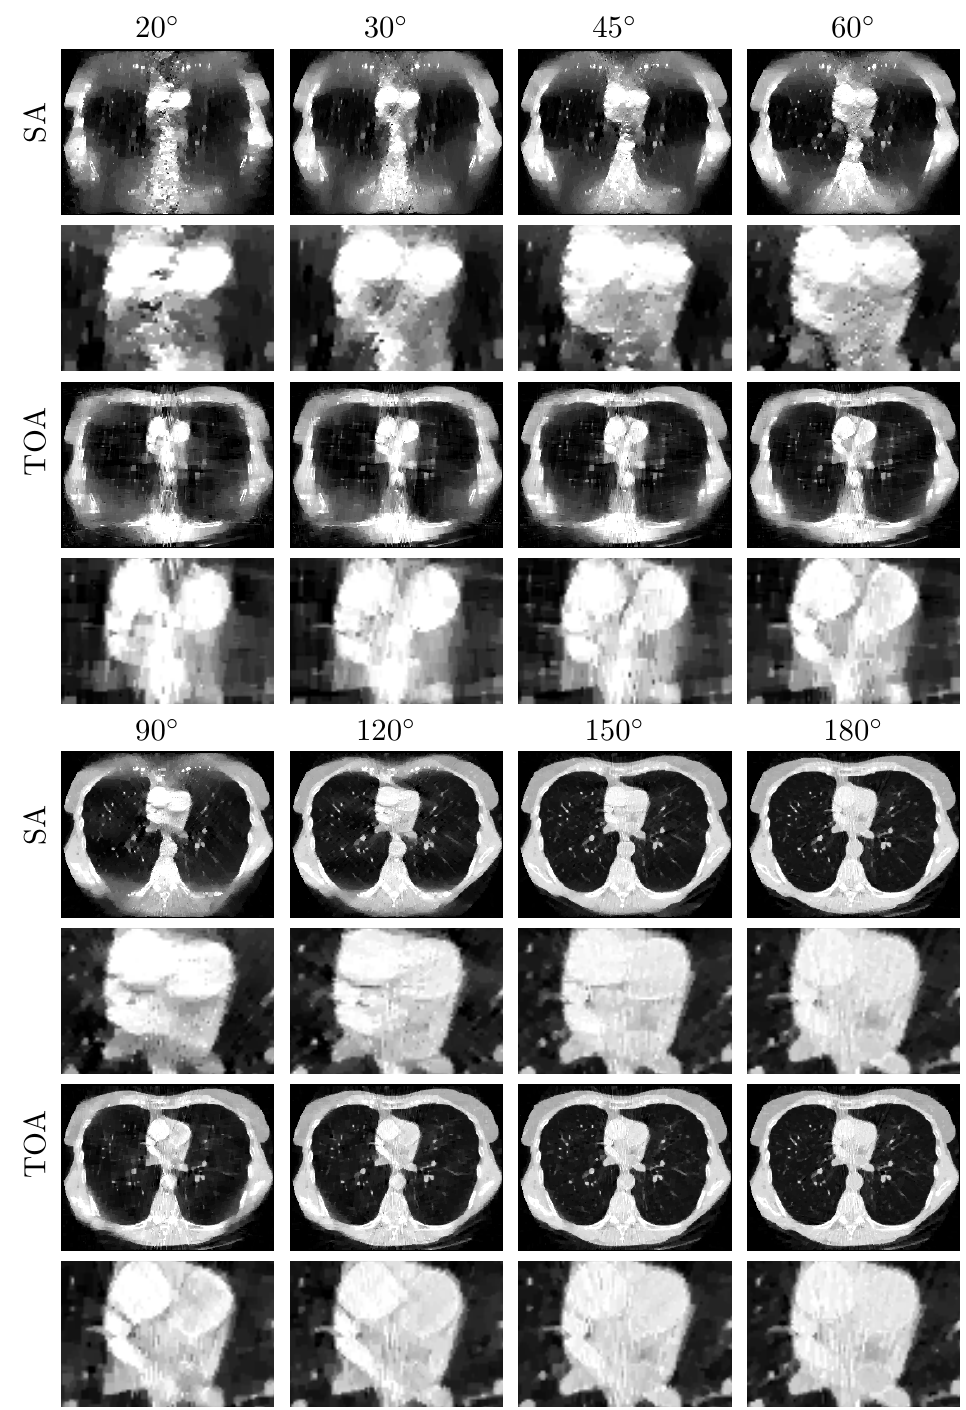
Figure 7. VMIs (rows 1, 3, 5, and 7), along with their respective zoomed-in views (rows 2, 4, 6, and 8), of the chest phantom at 100 keV obtained from noisy data over SAs (rows 1&2 and 5&6) and TOAs (rows 3&4 and 7&8) of LAR 20 ◦ , 30 ◦ , 45 ◦ , 60 ◦ , 90 ◦ , 120 ◦ , 150 ◦ , and 180 ◦ , respectively, by use of the two-step method. Display window: [0, 0.22] cm − 1